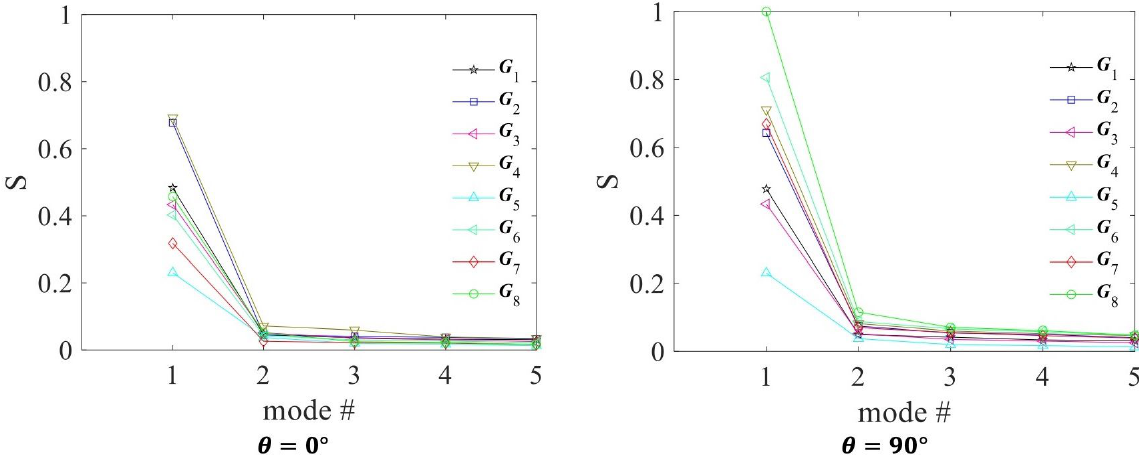
Figure 7: Normalized S estimated using [46] for the first five for all geometries listed in Table 1 and for θ = 0 ∘ (left) and θ = 90 ∘ (right)